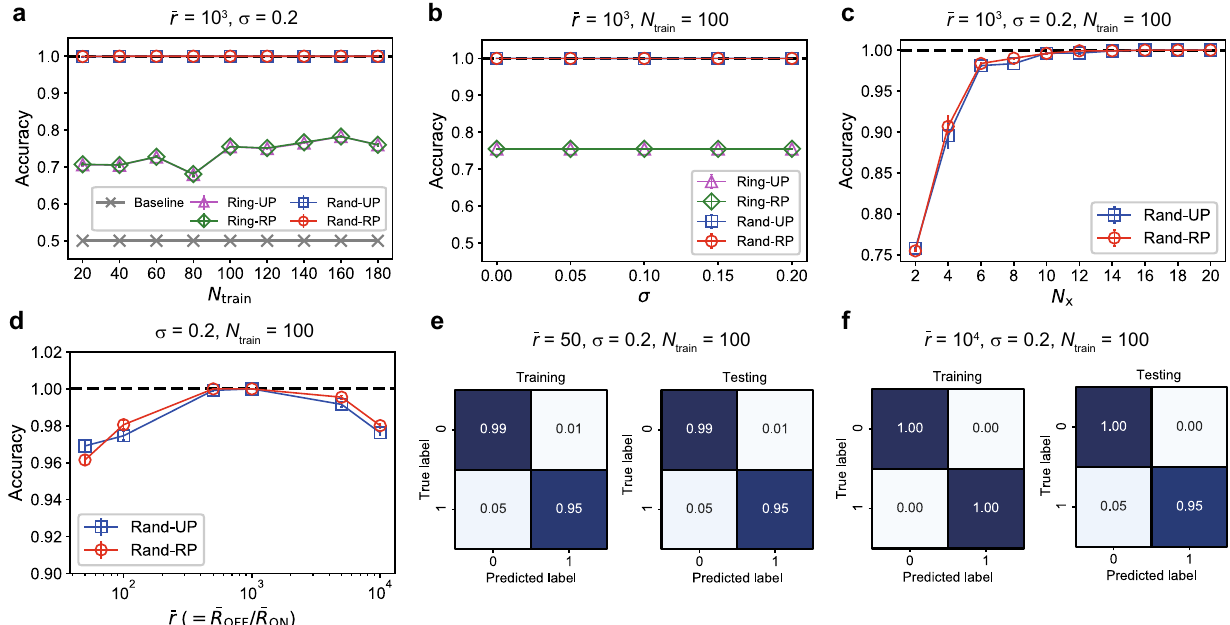
Figure 3. Results of the waveform classification task. ( a ) The classification accuracies for the four different network types when N train is varied. ( b ) The classification accuracies plotted against the variability parameter σ . ( c ) The classification accuracies when N x signals out of N m ( = 20 ) current signals were used for the readout. ( d ) The classification accuracies plotted against the average ON/OFF resistance ratio ¯ r . ( e ) The confusion matrices for ¯ r = 50 . ( f ) The confusion matrices for ¯ r = 10 4